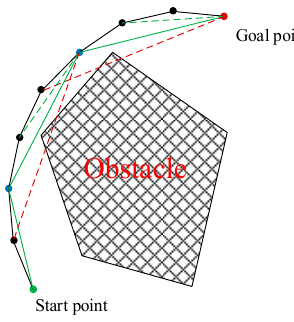
Figure 4. Diagram of smooth optimization.